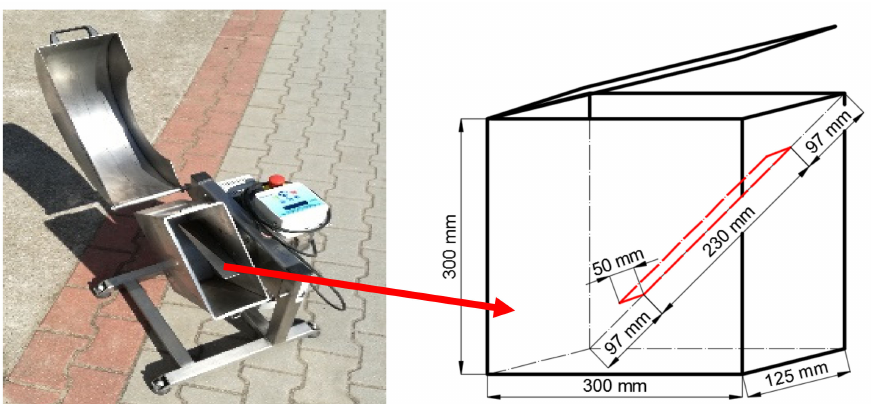
Figure 3. Test stand to mechanical durability with rotating